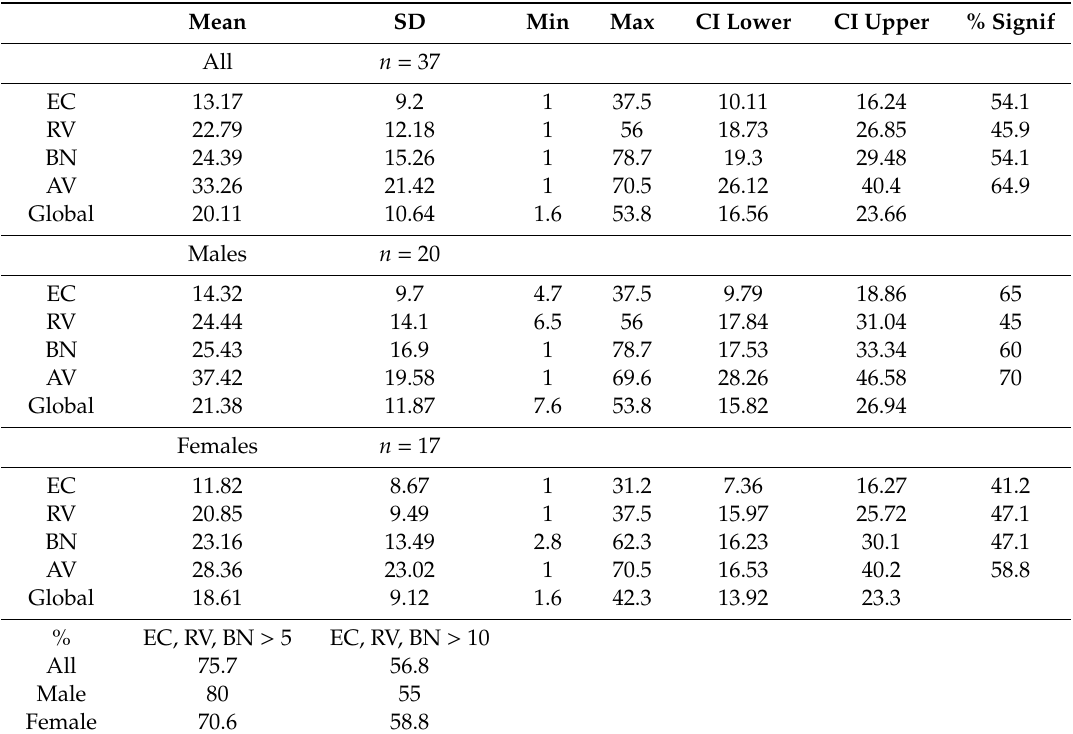
Table 9. Self-reported ease of communication (APHAB) at 18 months post-hearing aid fitting.